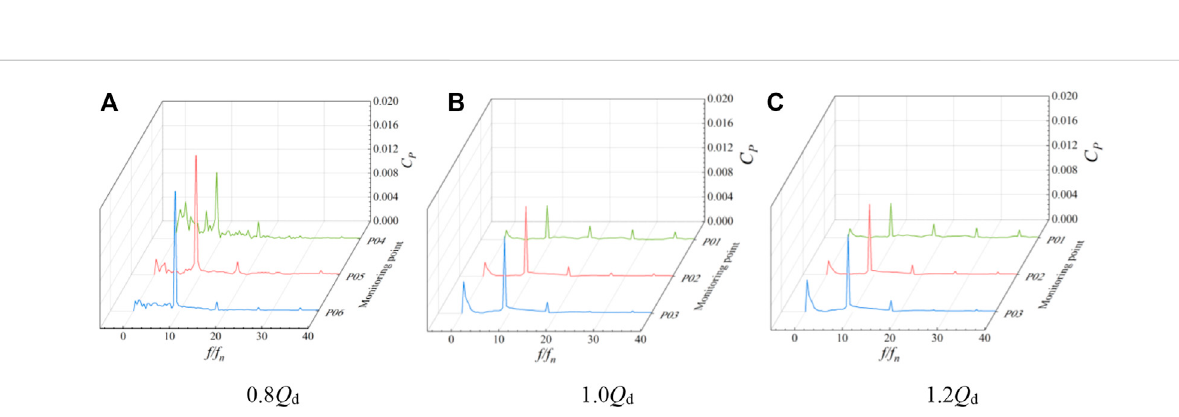
frequency (rotational frequency f n (cid:1) 67 . 6 Hz), the Y -axis is the monitoring points of different sections, and the Z -axis is the amplitude of the pressure pulsation coef fi cient.